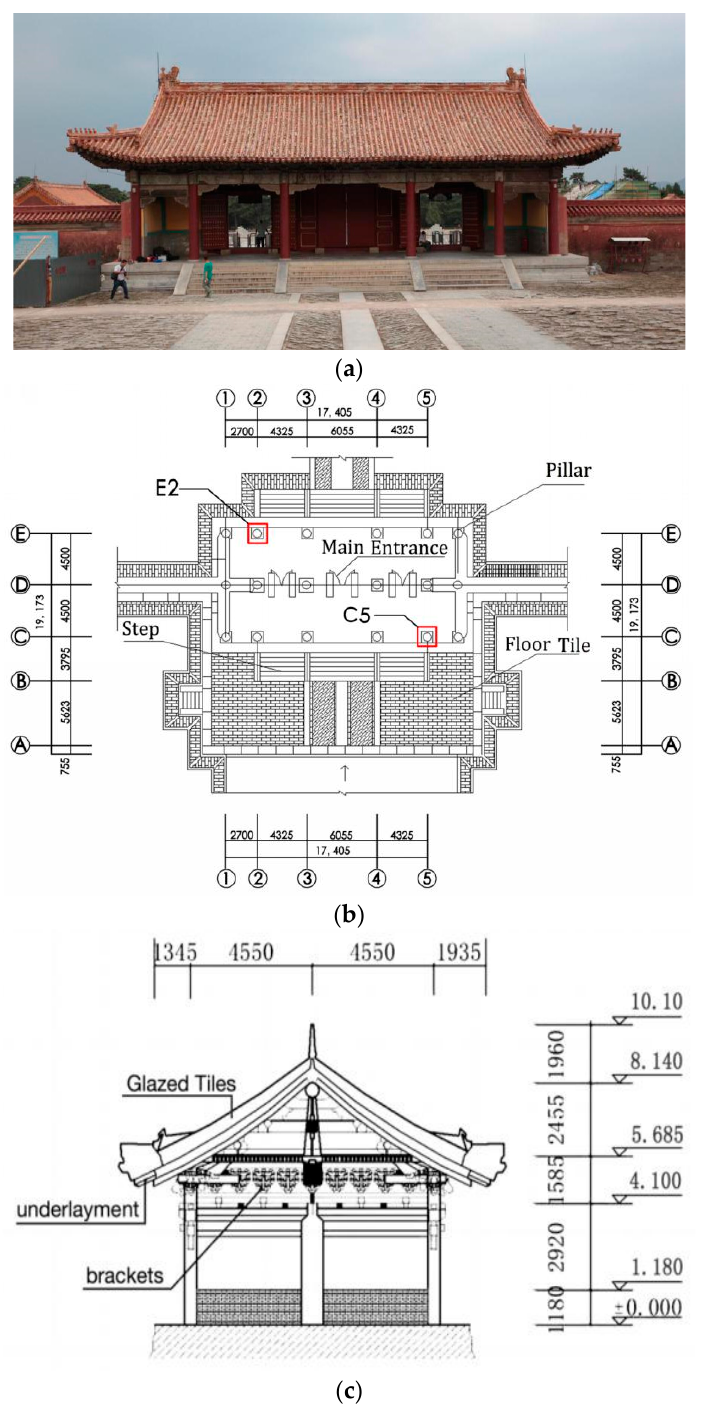
Figure 1. Ancient building: ( a ) Scene; ( b ) Floor plan of ancient building; ( c ) Section of ancient building.